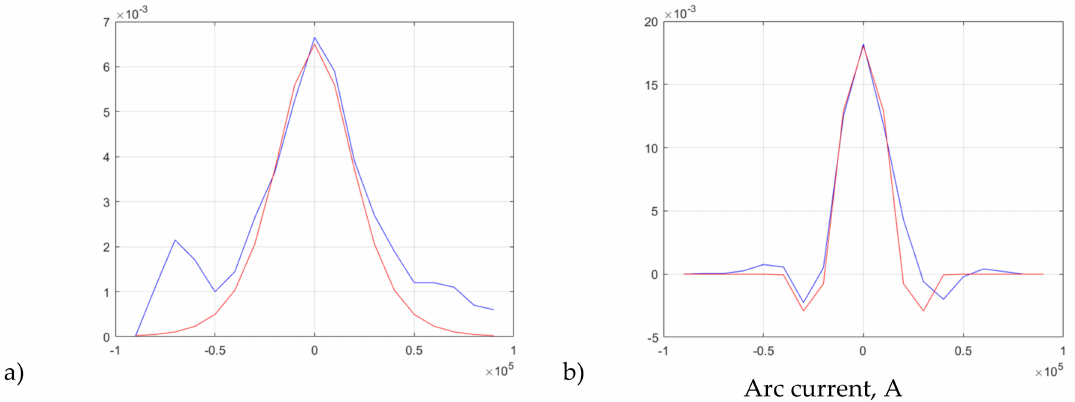
Figure 4. Dependences of the change R d , obtained on the basis of experimental data and when approximating the curves of the volt-ampere characteristic using ( a ) hyperbolic tangent functions; ( b ) modified Mexican hat